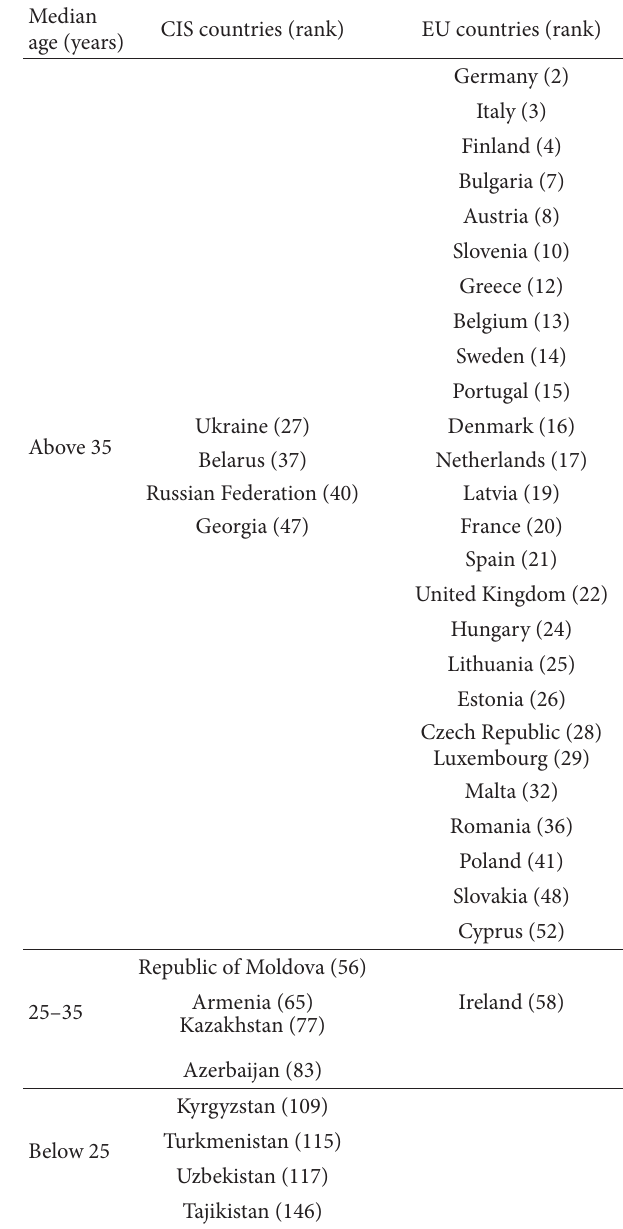
T 1: Distribution (grouping) of CIS and EU countries by medi- an age,